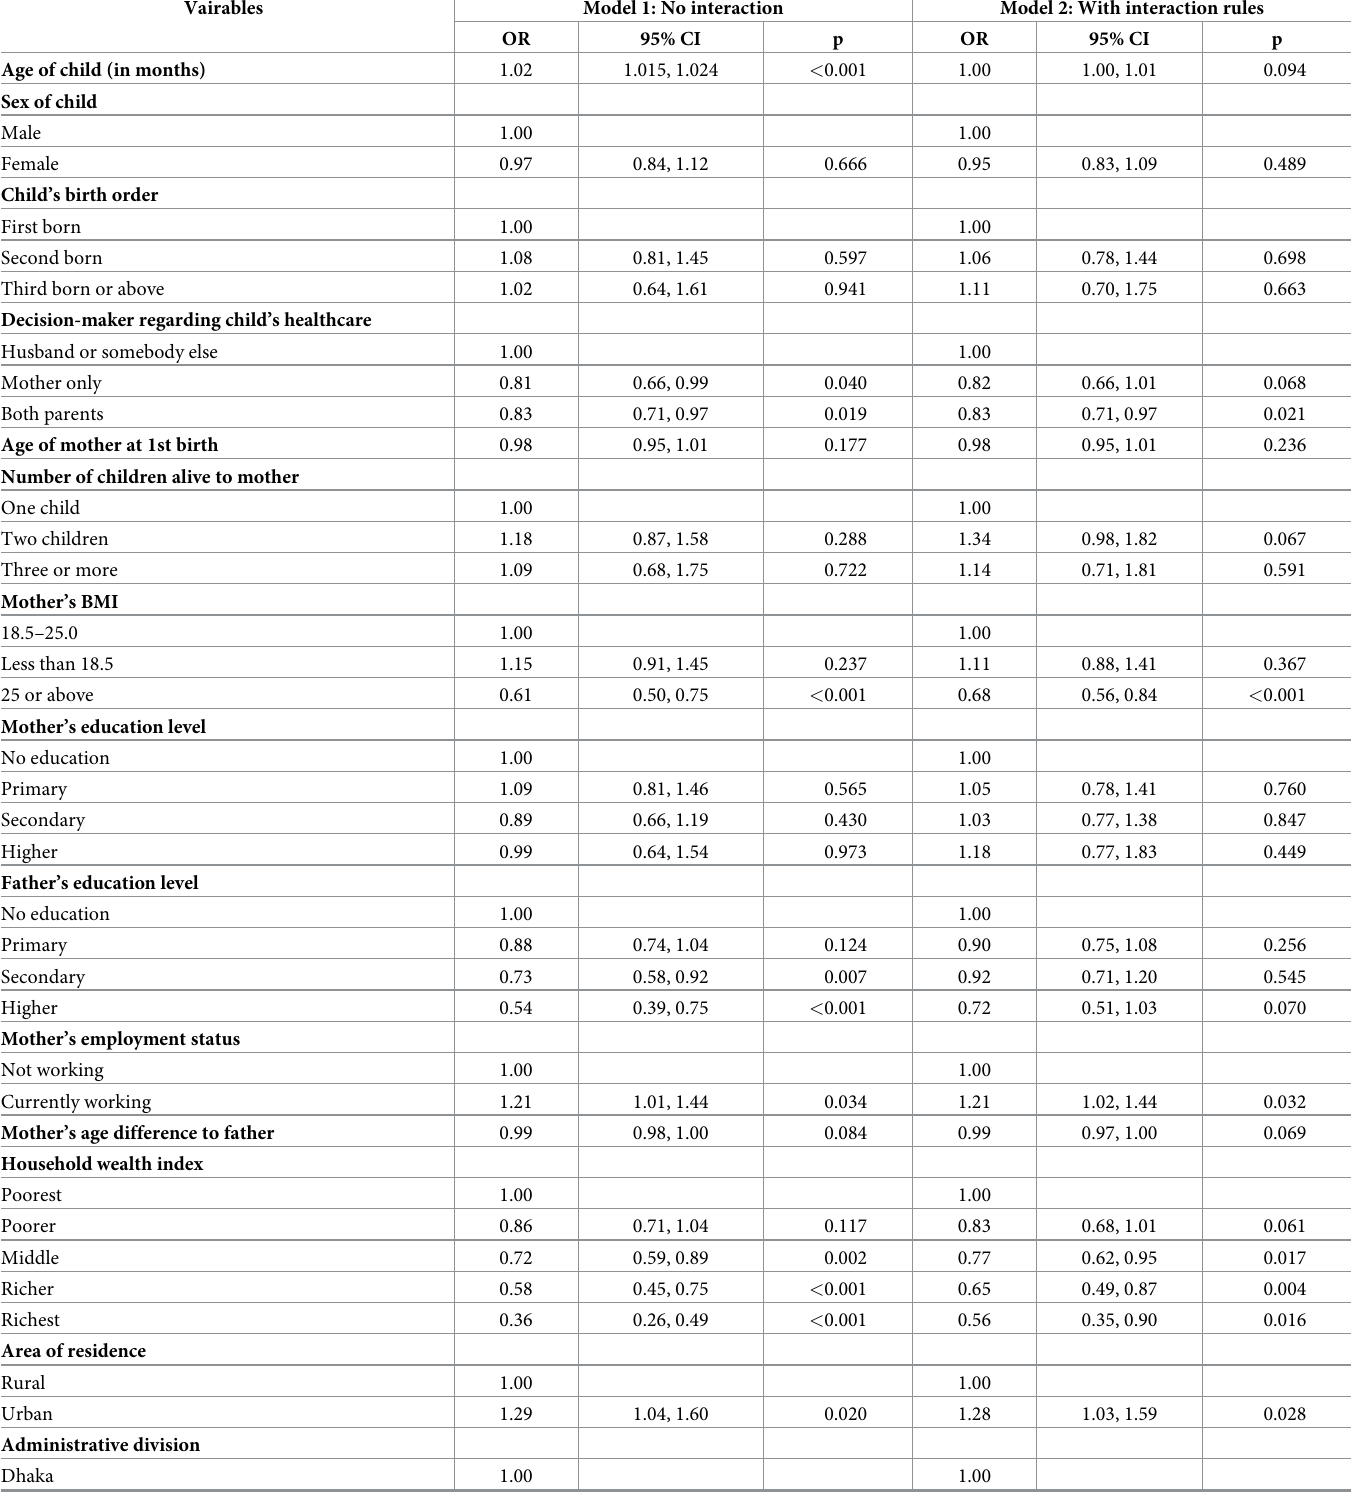
Table 3. Odds ratios (OR) and associated confidence intervals (CI) and p-values (p) from the two logistic regression models.